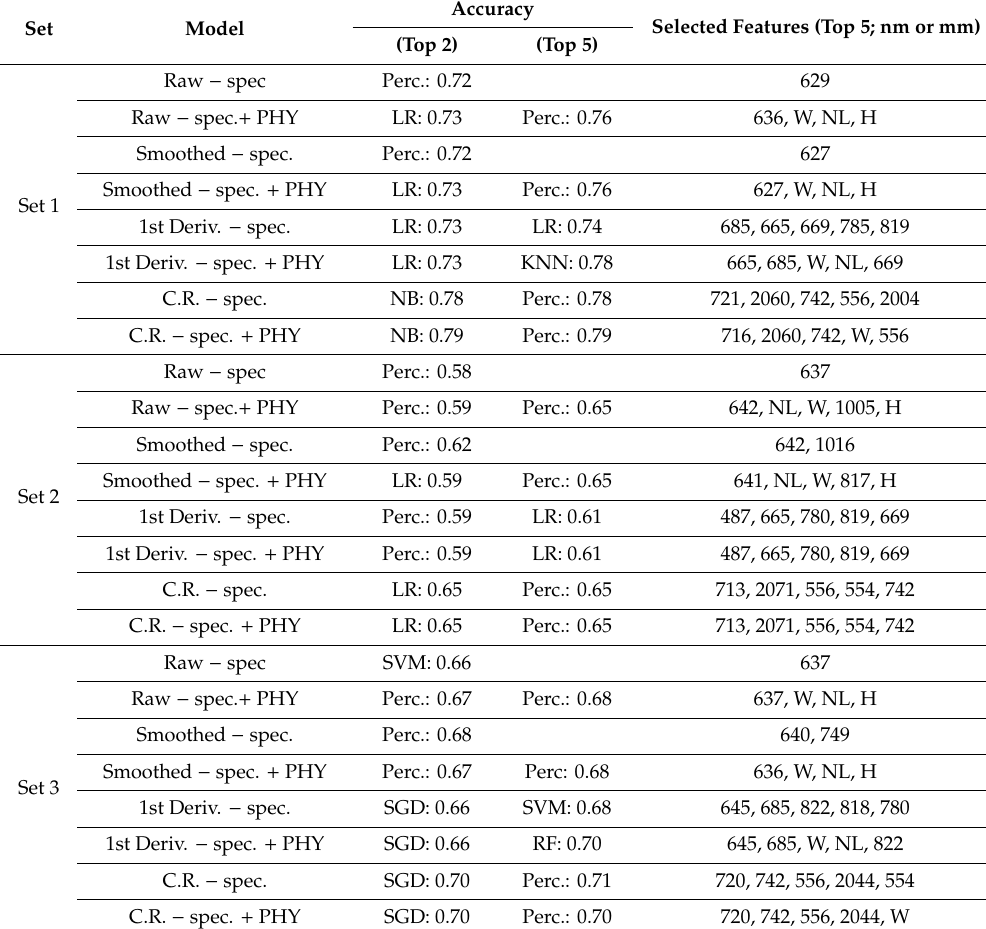
Table 9. Results for pod maturity classification. Note the superior performance of continuum-removal model in all